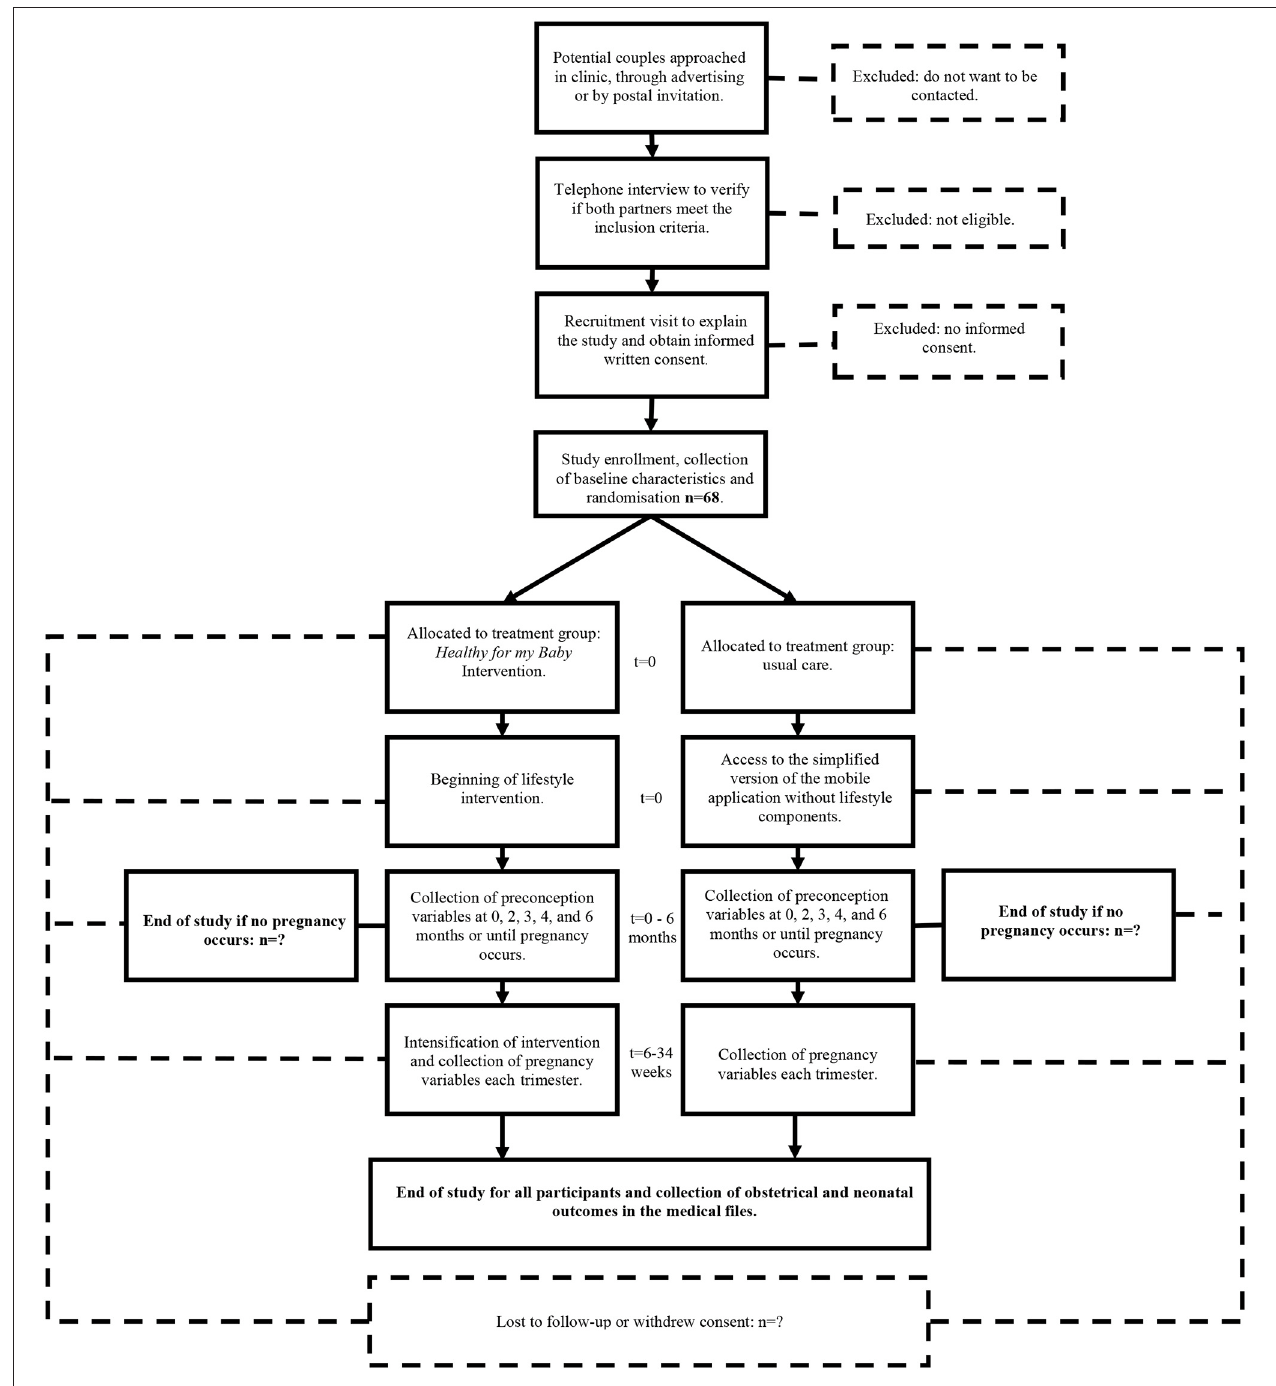
FIGURE 1 | Participant